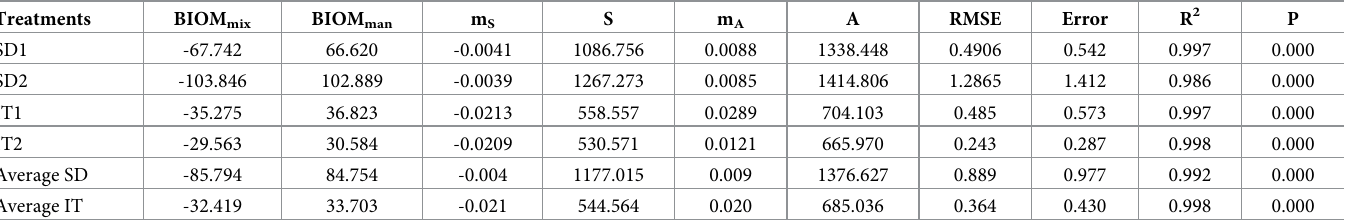
Table 2. Estimated values of the coefficients of Eq 3 for the sowing date (SD) and irrigation (IT) treatments oriented to biomass accumulation. Treatments BIOM